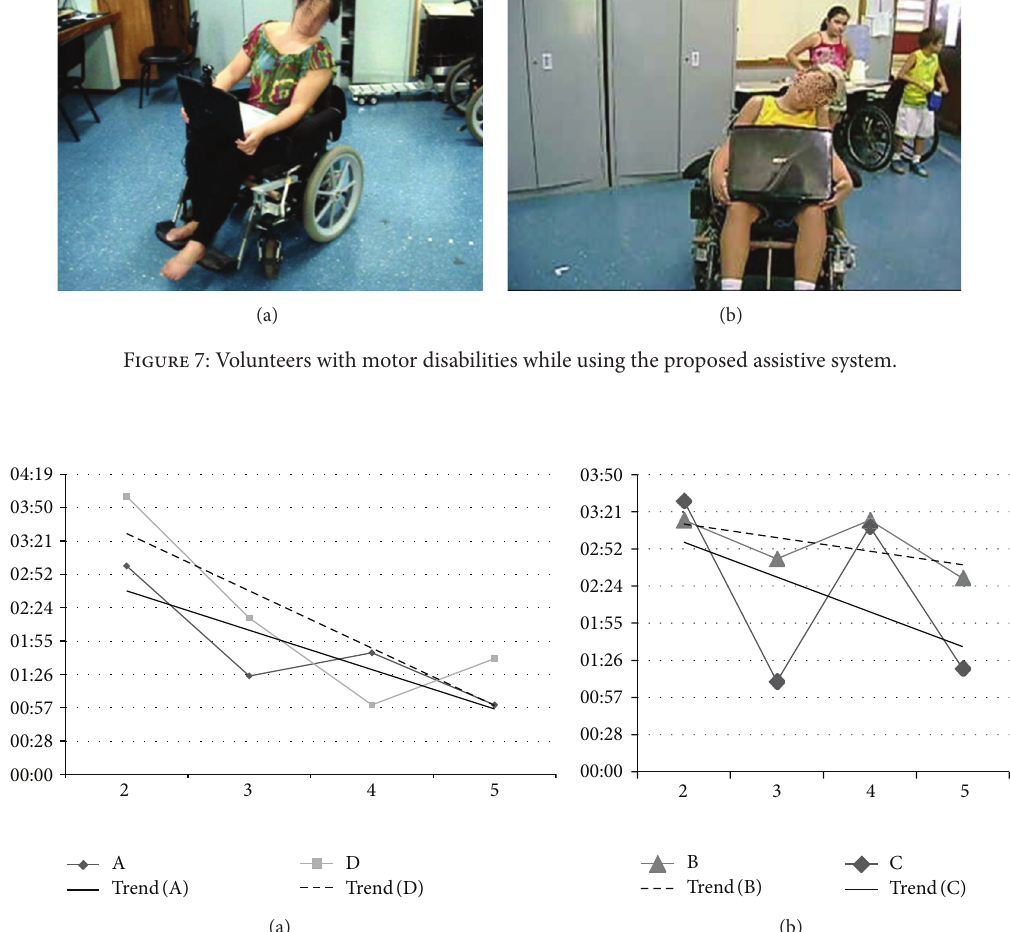
left when the angle 𝛾 is negative (head movements to the left), also according to the kinematic control law (9).